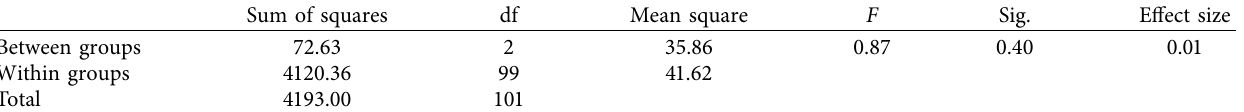
Table 2: One-way ANOVA results.